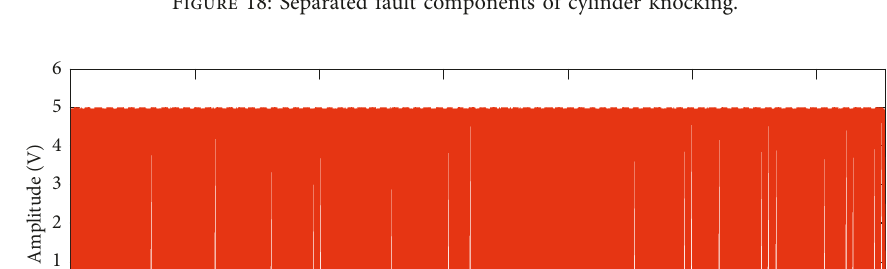
Figure 18: Separated fault components of cylinder knocking.